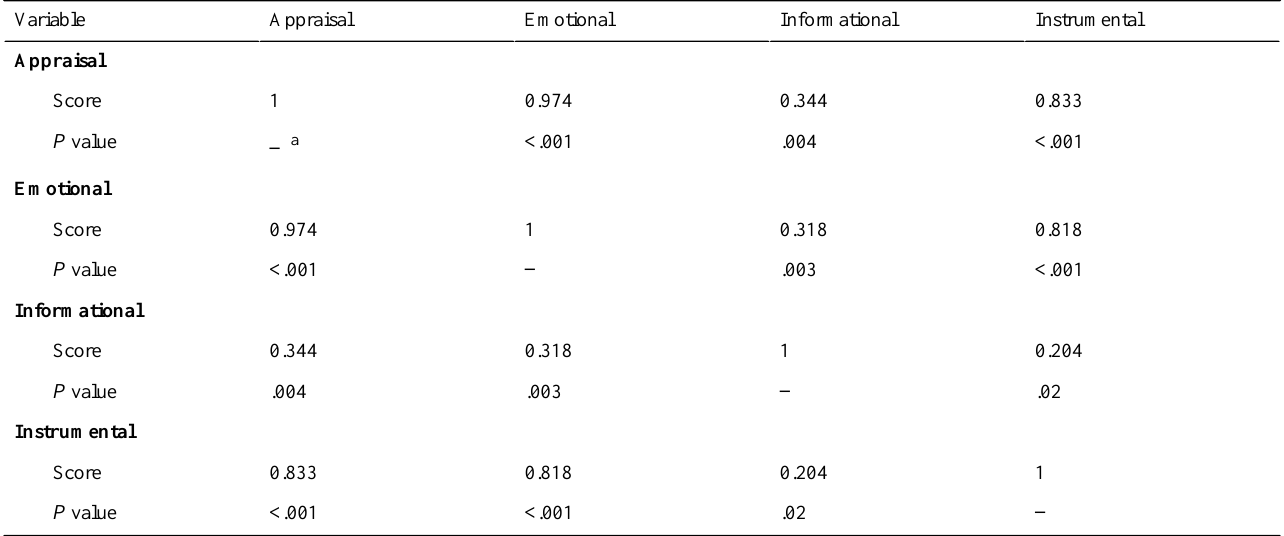
Table 2. Network correlation test results.